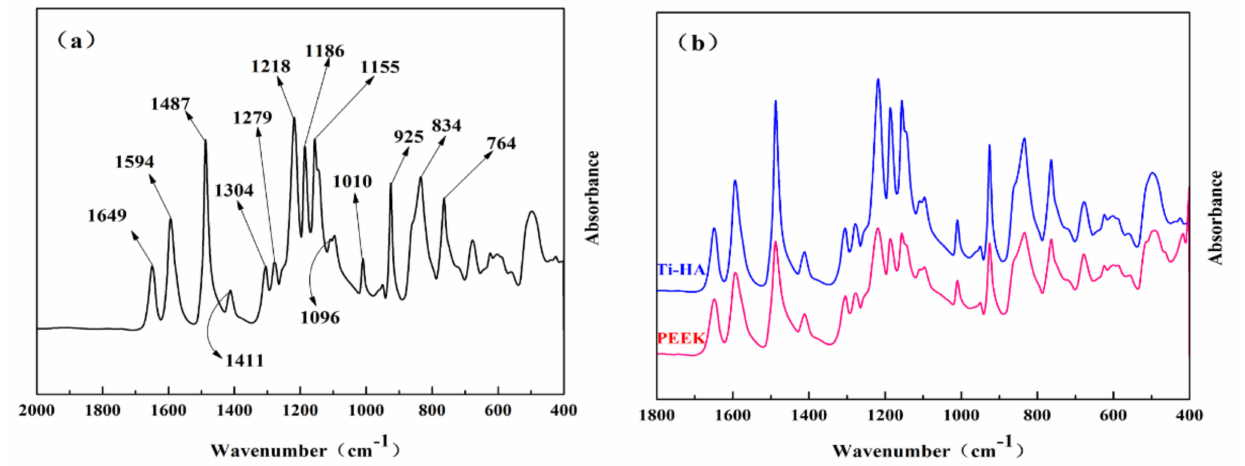
Figure 10. ATR FT-IR spectroscopy graphs of PEEK: ( a ) the infrared spectrum of the fingerprint region of coated PEEK; ( b ) the comparison of coated and uncoated PEEK in the infrared spectrum.